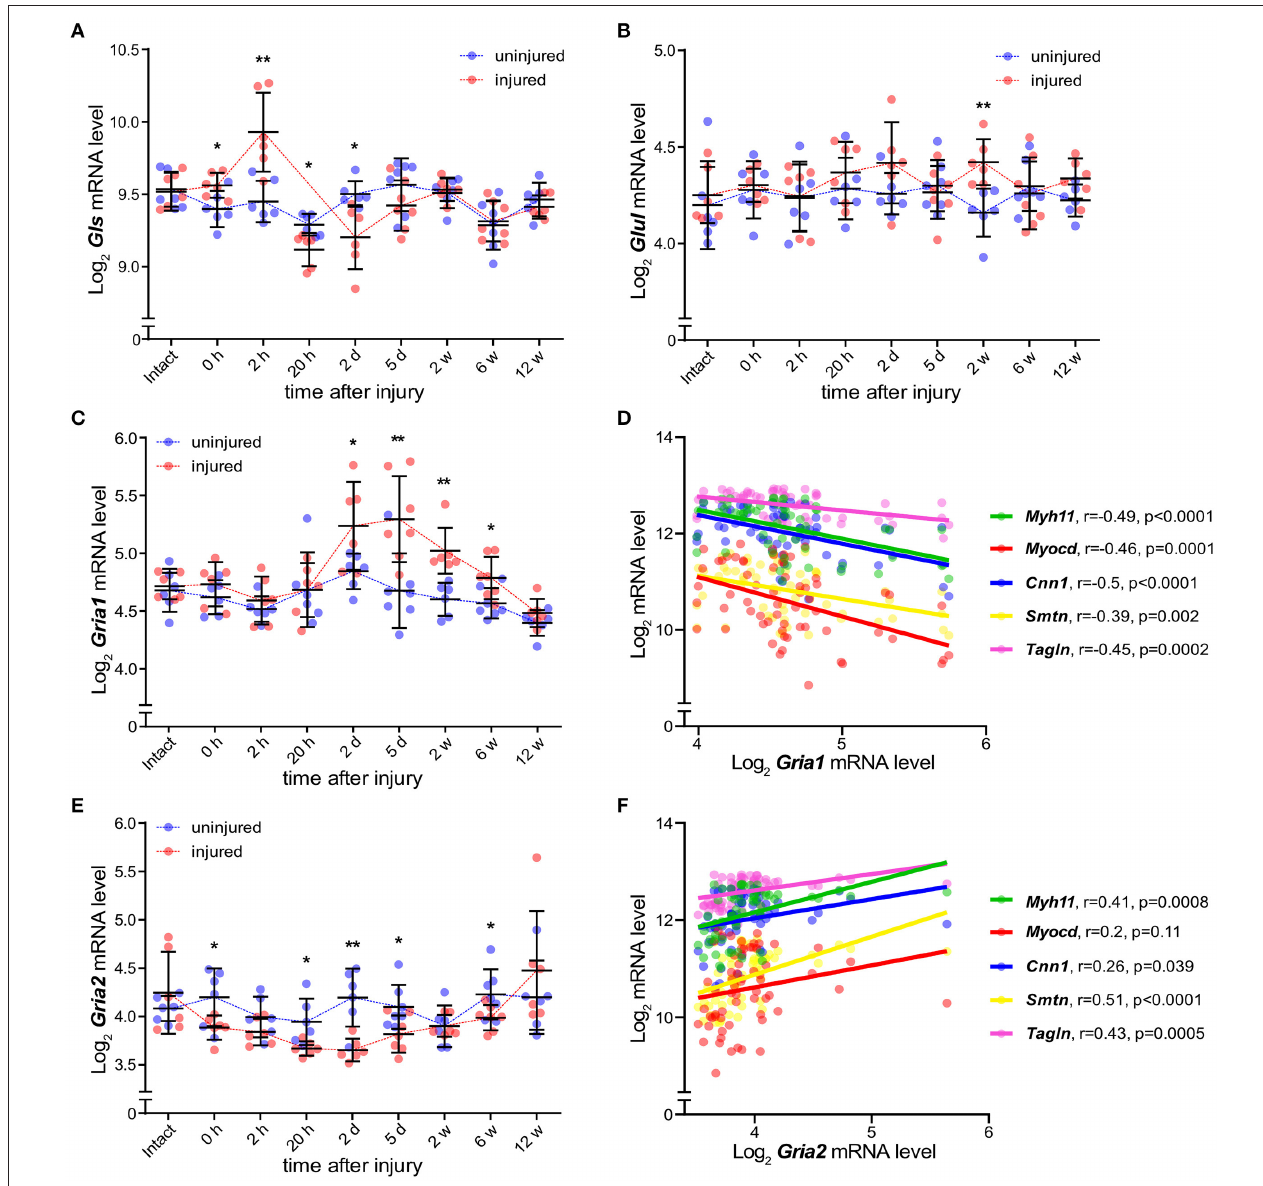
FIGURE 3 | AMPA-type receptors Gria1 and Gria2 associate with SMC phenotypic switch in arterial repair. (A,B) Dot plots showing mRNA levels of Gls (A) and Glul (B) during the course of carotid artery injury and healing in injured (red) and uninjured (blue) rat carotid arteries ( n = 6–7 per time point) over the course of 12 weeks. (C) mRNA levels of Gria1 during the course of rat carotid artery injury and healing response described in (A,B) . (D) mRNA levels of Gria1 plotted versus typical markers of smooth muscle cells in injured arteries from all time points ( n = 64) (r P = Pearson r). (E) mRNA levels of Gria2 during the course of rat carotid artery injury and healing response described in (A,B) . (F) mRNA levels of Gria2 plotted versus typical markers of smooth muscle cells in injured arteries from all time points ( n = 64) (r P = Pearson r). mRNA levels were measured by microarray assay. Dots represent log 2 mRNA levels. Middle bar indicates the median mRNA level and error bars represent SD. * p < 0.05, ** p < 0.01, calculated using Kruskal-Wallis ANOVA test followed by Bonferroni-Dunn correction for multiple comparisons. Myosin heavy chain 11 ( Myh11 , green), Myocardin ( Myocd , red), Calponin 1 ( Cnn1 , blue), Smoothelin ( Smtn , yellow), and Transgelin ( Tagln ,